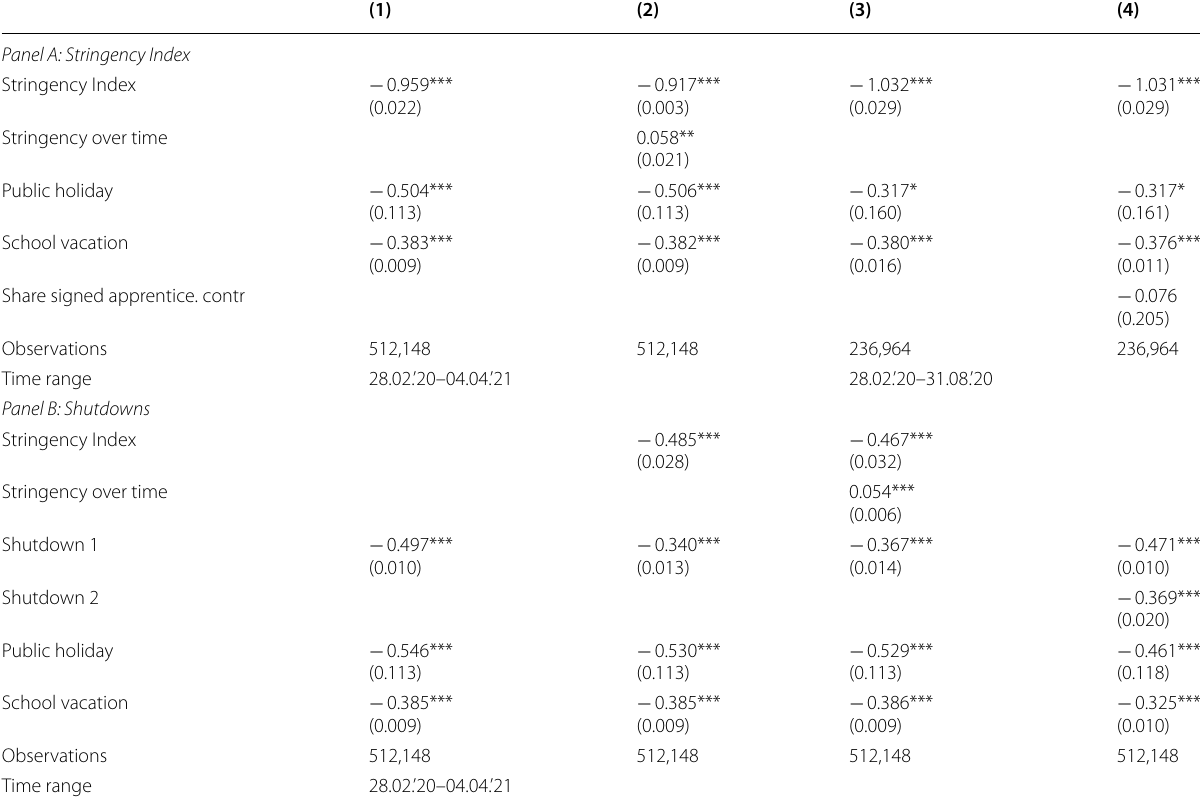
Table 6 Main results,